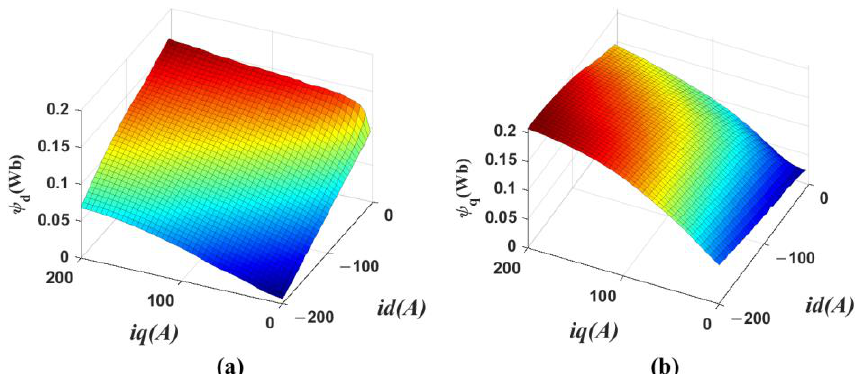
Figure 5. Flux variation of experimental prototype with d-q axis current: ( a ) d-axis flux surface; ( b ) q-axis flux surface.